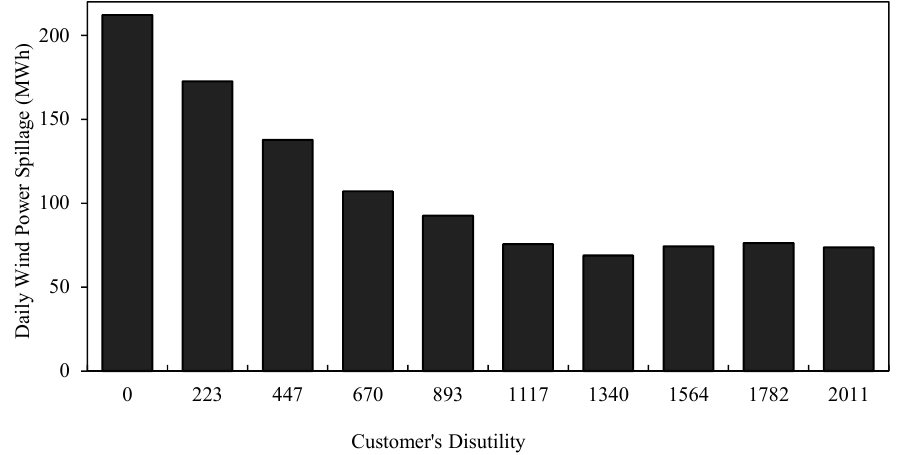
Figure 6. The daily wind power spillage vs. customer disutility.